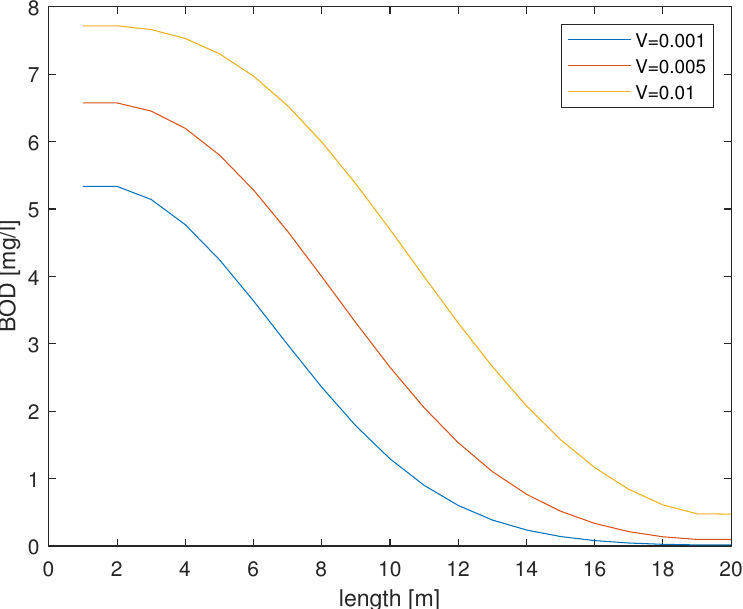
Figure 9. BOD distribution including diffusion at different velocities in the same time moments. An interesting phenomenon occurs when diffusion is not considered, as shown in Figure 10 (cf. Figure 8a). Once a pollutant is introduced into the water, the lack of diffusion results in a prolonged period of dangerous conditions in the river, only after the water masses have moved over a certain length and time does the concentration of the pollutant